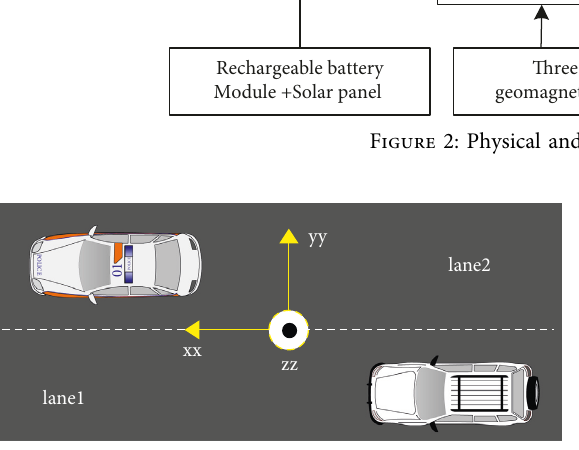
Figure 3: Orientation of the three-axis geomagnetic sensor.